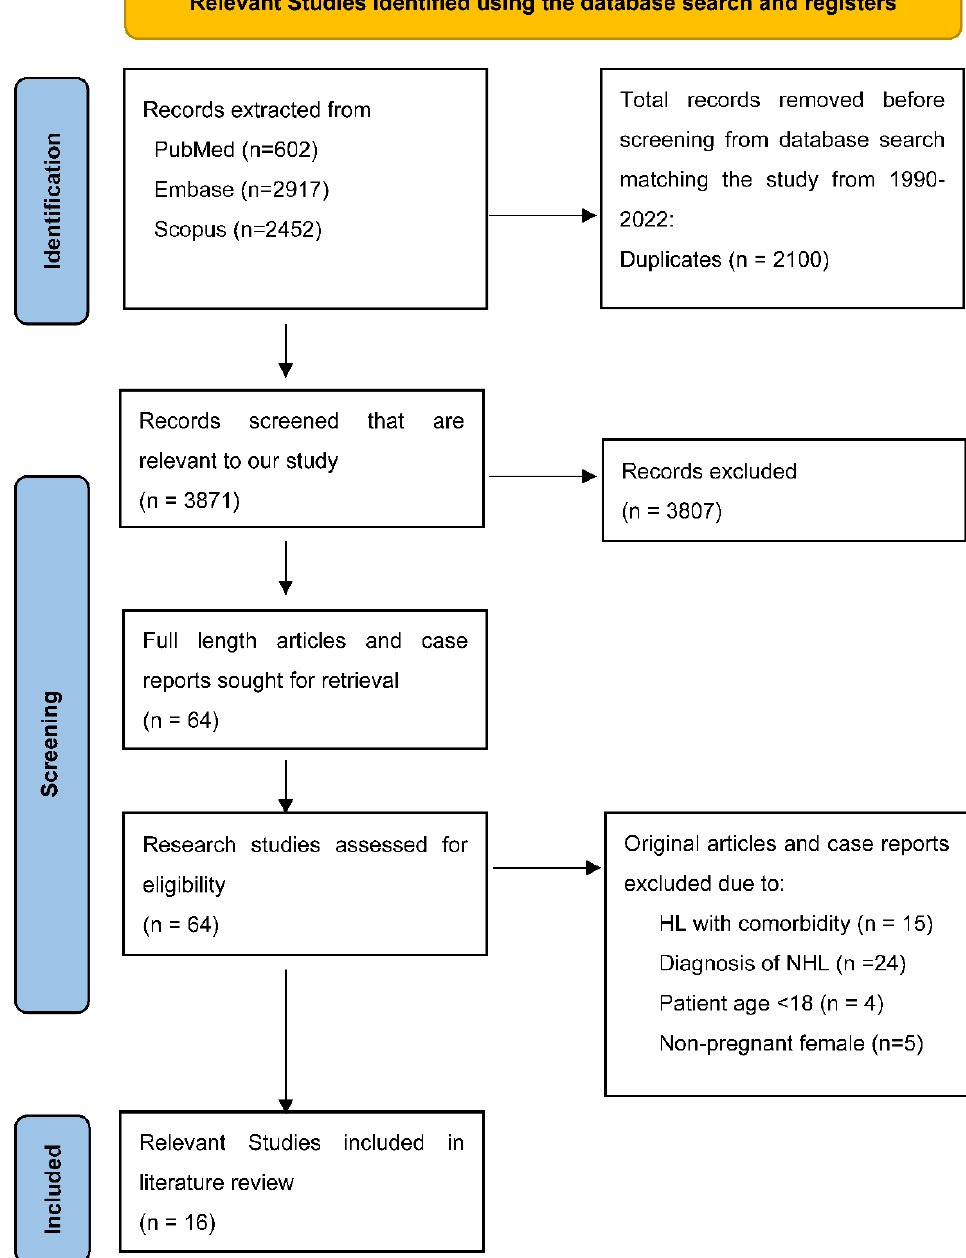
Figure 6. PRISMA 2020 flow diagram for new systematic reviews which included searches of data- bases and registers only. databases and registers